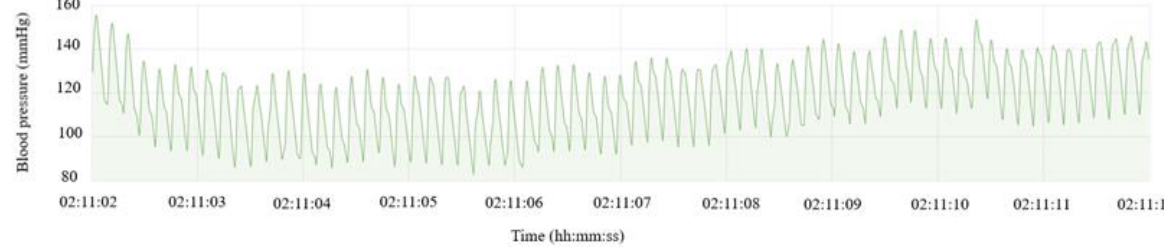
Figure 3. Ten seconds of calibrated data.